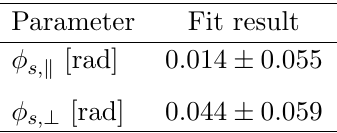
Table 4 . Results of the polarisation-dependent (cid:12)t for the CP violation (cid:12)t. Uncertainties shown do not include systematic